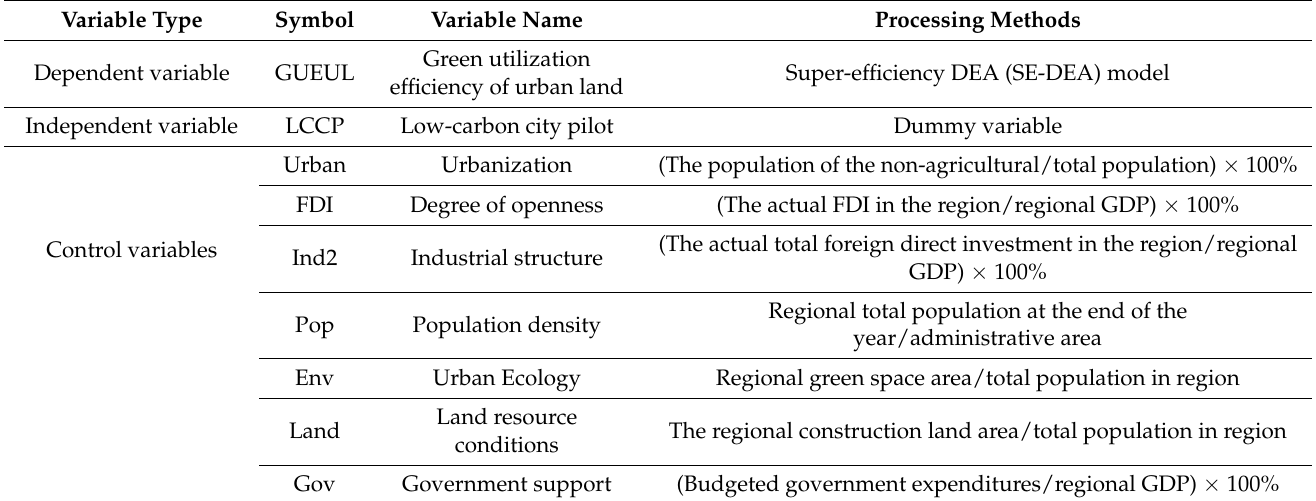
Table 1. Primary variables and processing